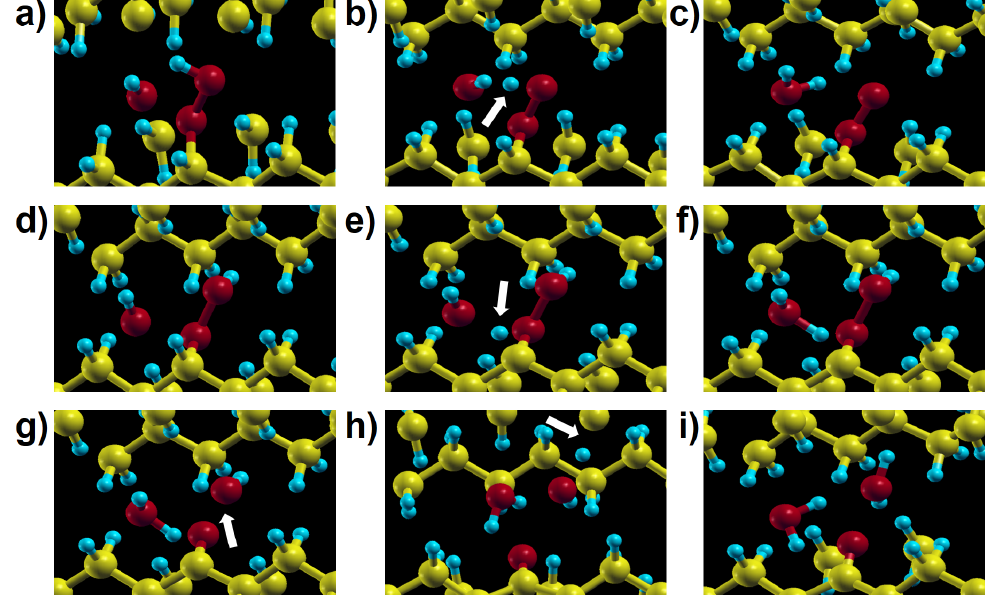
Figure 13. Intermediate steps of reactions 9a (panels ( a – c )) and 9b (panels ( d – i )) in Figure 2 in crystalline PE. The outcome of reaction 9b in the solid is different from the analogous one in the molecular model (Figure 12d–g), because here the remaining • OH radical reacts with a neighbouring chain (see the arrow in panel ( h )) giving one more water molecule (panel ( i )).